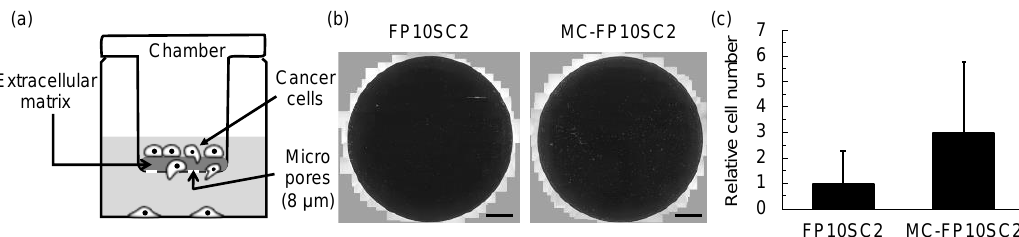
Figure 3. Evaluation of the degradation ability of extracellular matrices. ( a ) Schematic image of Boyden chamber system. ( b ) Typical images of migrated cancer cells with degradations of extracellular matrices. Bars: 1 mm. ( c ) Changes in the degradation abilities of extracellular matrices before and after stimulation with MΦ -CM measured using a Boyden chamber system. Values were normalized with an average value of FP10SC2. Standard deviations are indicated as error bars in the graph. P < 0.05.